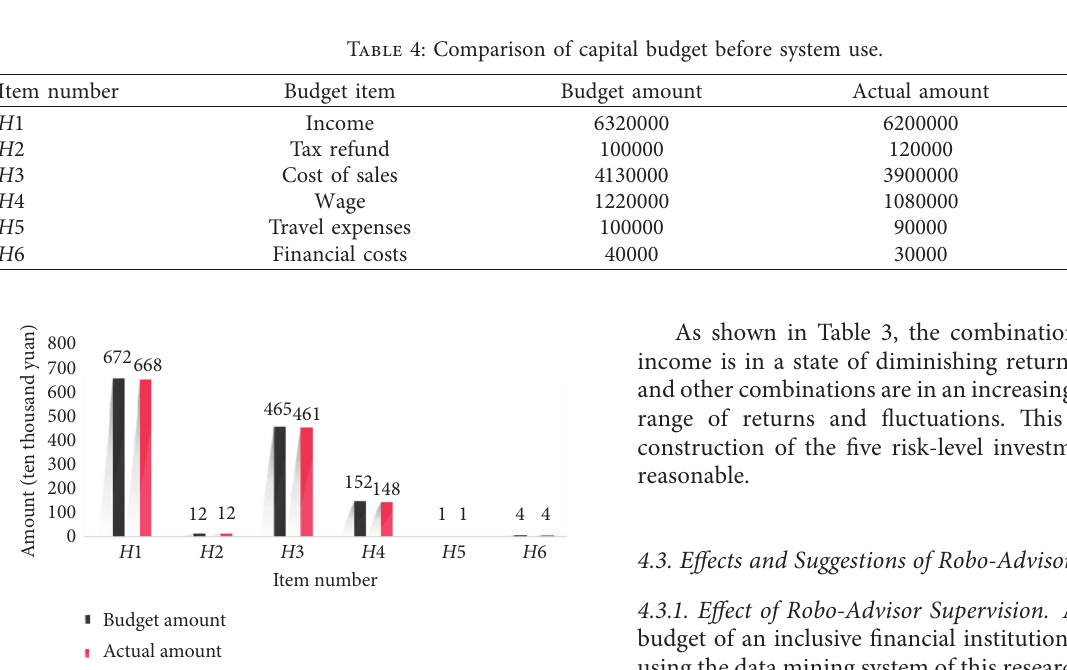
Figure 11: Comparison of fund budget after system